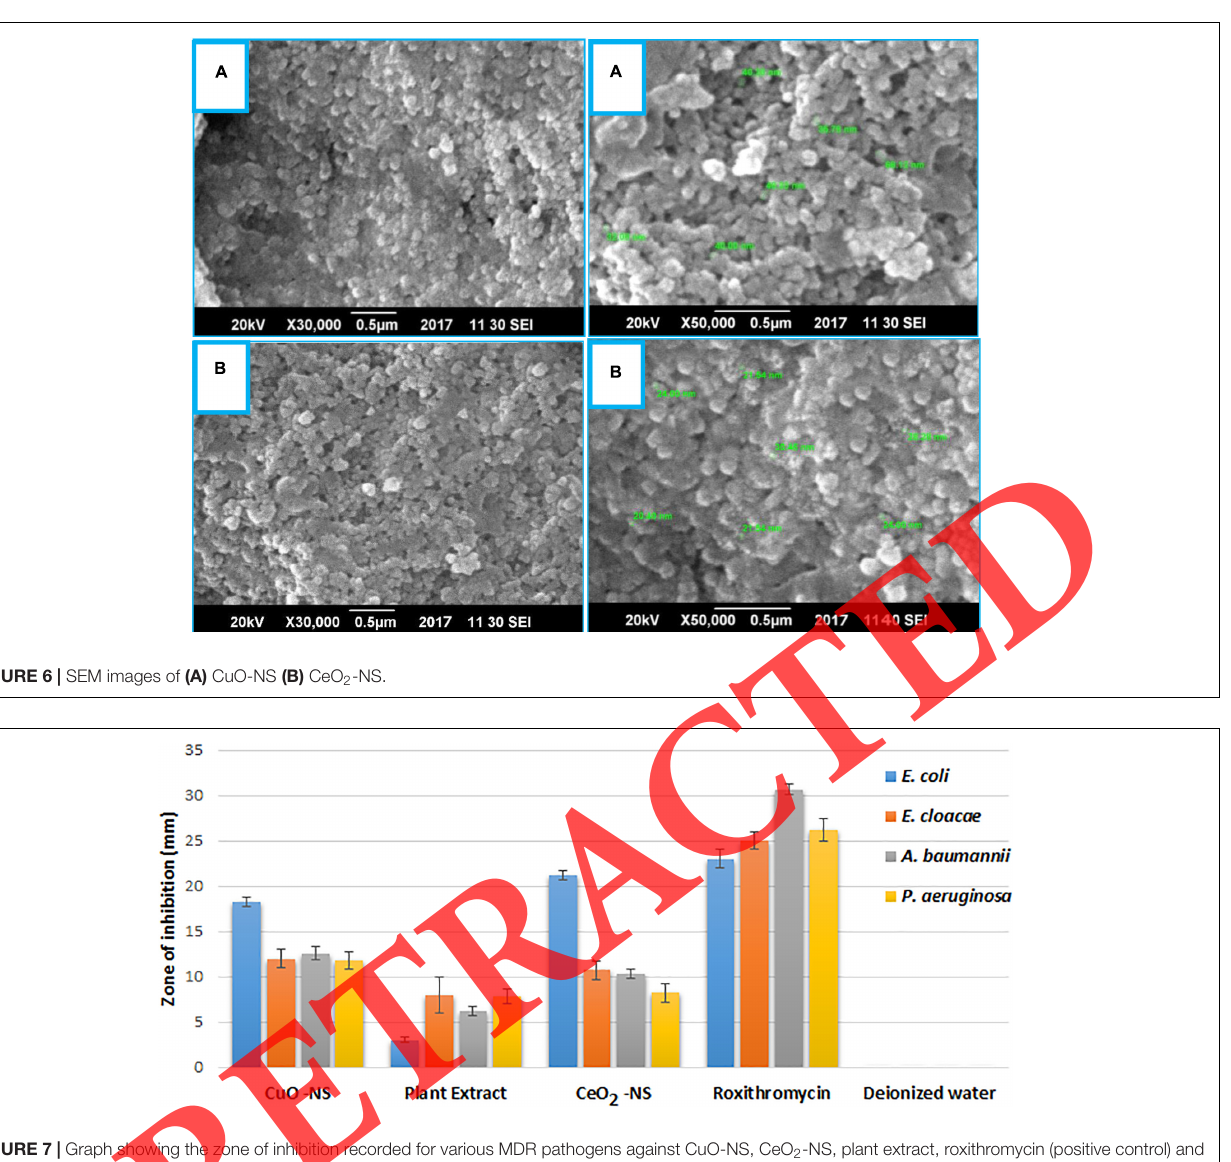
FIGURE 7 | Graph showing the zone of inhibition recorded for various MDR pathogens against CuO-NS, CeO 2 -NS, plant extract, roxithromycin (positive control) and deionized water (negative